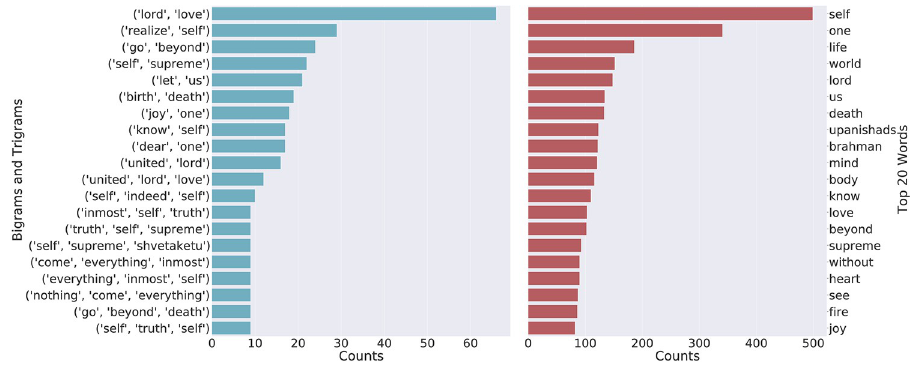
Fig 3. Leading bigrams and trigrams for the Bhagavad Gita and Upanishads by Eknath Easwaran.